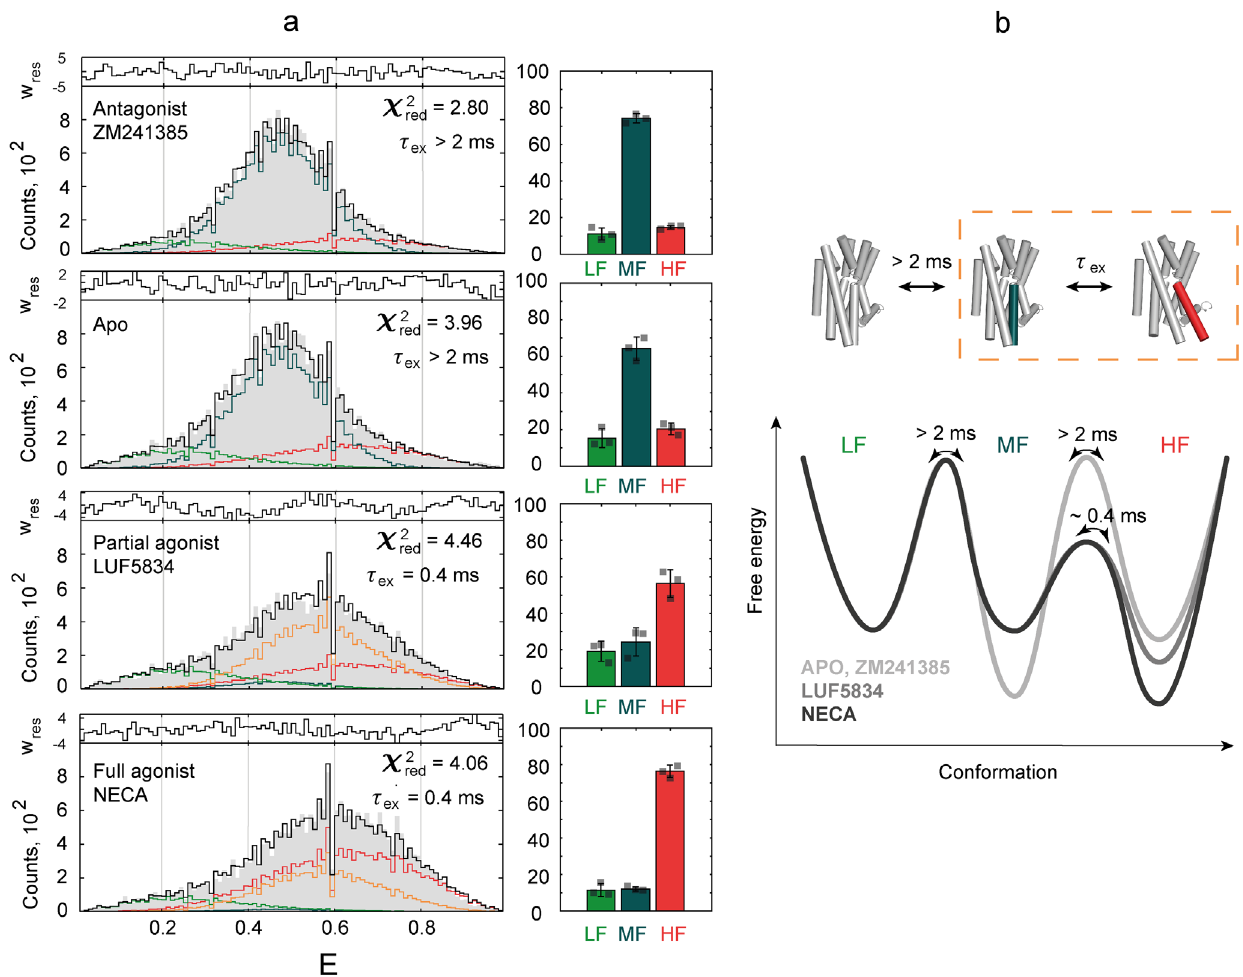
Fig. 3 PDA quanti fi es parameters of the A 2A AR three-state action model by fi tting FRET ef fi ciency distributions. a Experimental distributions of 1-ms- long time bins derived from fl uorescence bursts of double-labeled A 2A AR (gray area) were fi tted with a three-state model. The resulting fi t (black line) is a sum of distributions simulated for molecules that stay in the LF (light green line), MF (dark cyan line), or HF (red line) state during the entire simulated time bin, and the distribution for molecules that sample both MF and HF states within the time bin (orange line). The fi tting residuals are shown on the top of each panel. The bar charts on the right show relative populations of the three states, with error bars representing SD of n = 3 technical replicas with different protein aliquots. Individual data points are shown as gray squares, source data are available online as Supplementary Data 2. b The three-state action model of A 2A AR and corresponding energy landscapes for the apo and agonist-bound receptor demonstrate relative populations of the states and inter-state exchange times. τ ex = (k 12 + k 21 ) − 1 is the relaxation time of the exchange between the MF and HF states (highlighted with dashed orange rectangle). TM6 is colored on the schematic (cylinder) representation of active (PDB: 5G53 70 , red) and inactive (PDB: 3EML 69 , dark cyan) structures